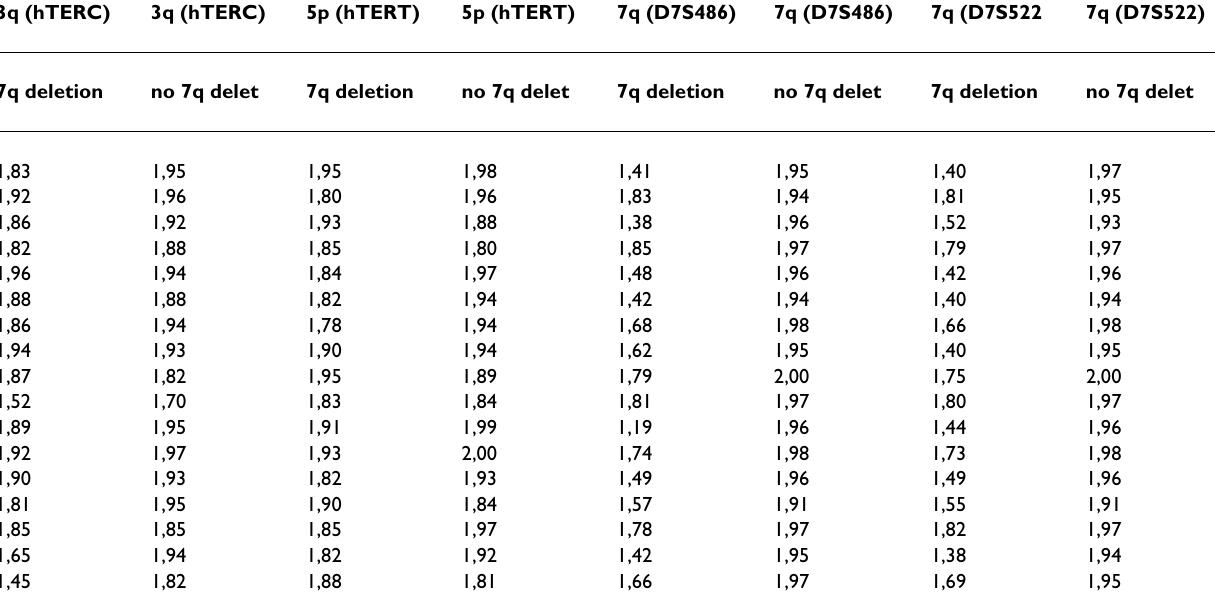
Table I: Results of triple color FISH reactions with probes for 7q31, hTERT and hTR given as the average number of signals per cell in each sample tested. 3q